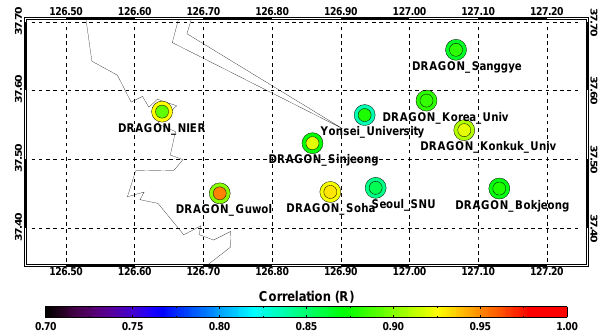
Figure 2. The distribution of correlation coefficients between AERONET AOD and MODIS AOD at 0.55µm with respect to dif- ferent spatial resolutions. The inner (outer) circle indicates the cor- relation between AERONET AOD and MODIS AOD with a reso- lution of 10km